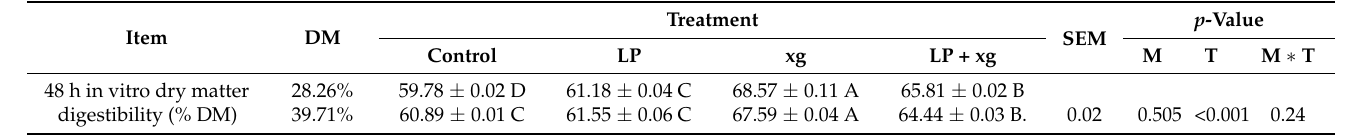
Table 8. In vitro dry matter digestibility of Stylosanthes